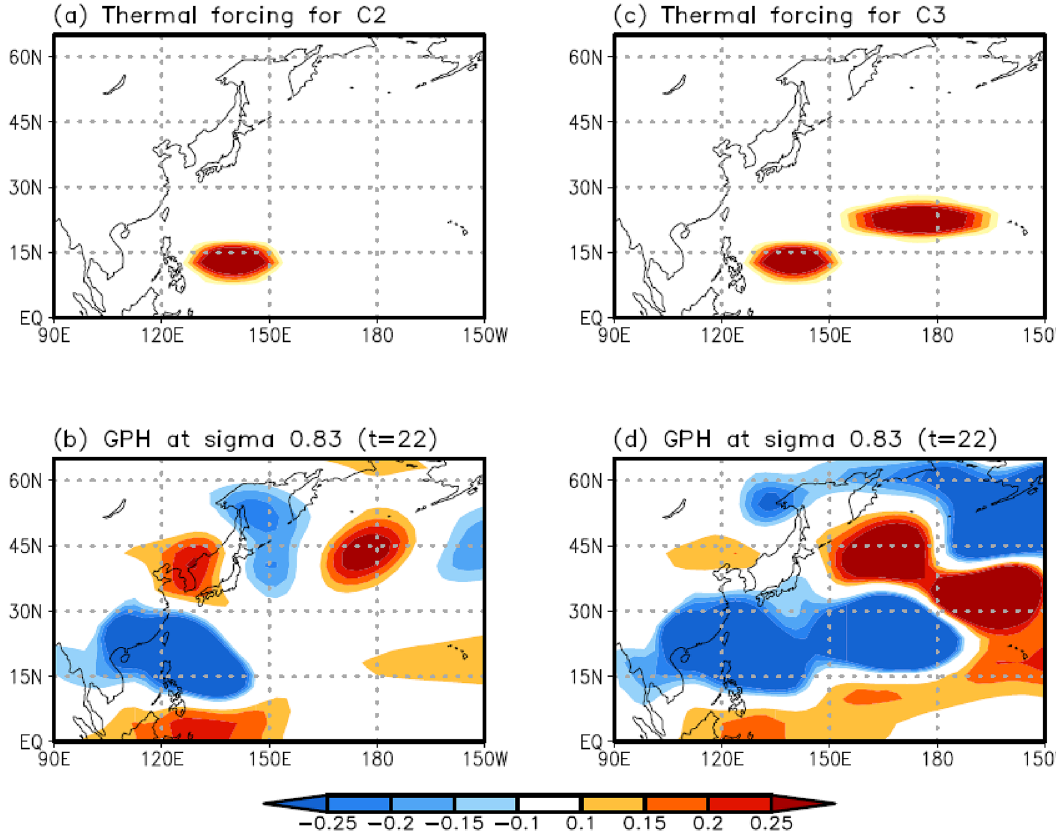
Figure 7. Horizontal distribution of the prescribed heating (K d –1 ) using the LBM experiment for ( a ) C2 and ( c ) C3. Maximal heating was set at a sigma level of 0.45. ( b ) and ( d ) show the 22-day integration results for the response of the 0.83 sigma level GPH anomaly fields to the prescribed heating for ( a ) and ( c ), respectively. Maps were generated using GrADS version 2.1.a1 (http:// cola. gmu. edu/ grads/ downl oads.